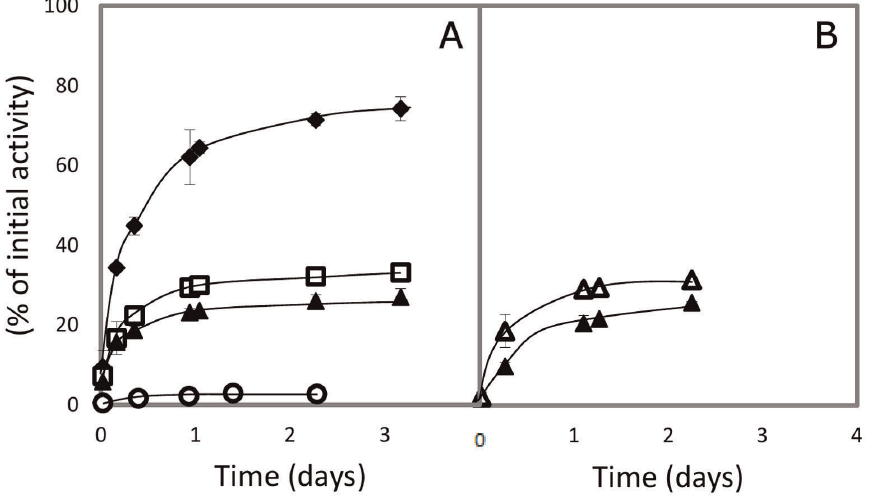
Figure 1. ATZ mineralization by Pseudomonas sp. ADP Rif R in soil contaminated with Primextra S-Gold. Time-course formation of 14 CO 2 from [ring-UL- 14 C]ATZ in ( A ) soil spiked with [ 14 C]ATZ plus increasing doses of Primextra S-Gold as follows: 5 6 ( X ), 20 6 ( % ) and 50 6 RD ( m ), without citrate amendment; or ( B ) soil spiked with [ 14 C]ATZ plus 50 6 RD of Primextra S-Gold and amended with 3.4 mg g 2 1 trisodium citrate ( D ) or non- amended ( m ). The average amount of 14 CO 2 released from non-inoculated control soil is shown for comparison ( # ) in ( A ). Data are means 6 SD of measurements from three replicated samples from at least two independent experiments under each condition. doi:10.1371/journal.pone.0037140.g001 PLoS ONE |